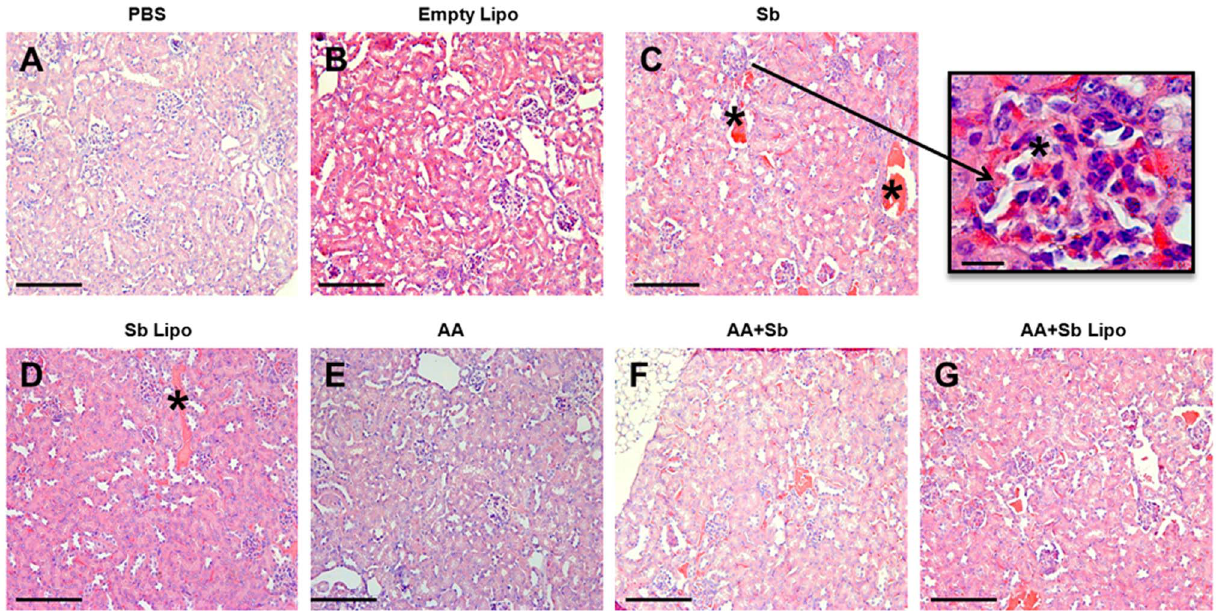
Figure 6. Histopathological analyses of the kidney from L.infantum infected mice submitted to different treatment regimens. (A) Phosphate-buffered saline (PBS). (B) Empty liposomes (Empty Lipo). (C) Trivalent antimony (Sb). (D) Antimony entrapped liposomes (Sb Lipo). (E) Ascorbic acid (AA). (F) Ascorbic acid in association with antimony (AA + Sb). (G) Ascorbic acid in association with antimony entrapped liposomes (AA + Sb Lipo). Bar =50 m m. Insert =25 m m, representing glomerular hyperemia. (A), (B) and (E) renal parenchyma exhibiting normal aspect. (C), (D), (F) and (G) renal parenchyma exhibiting active hyperemia. * Hyperemic vessels.